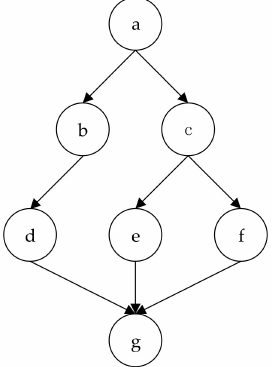
Figure 2. An example of direct